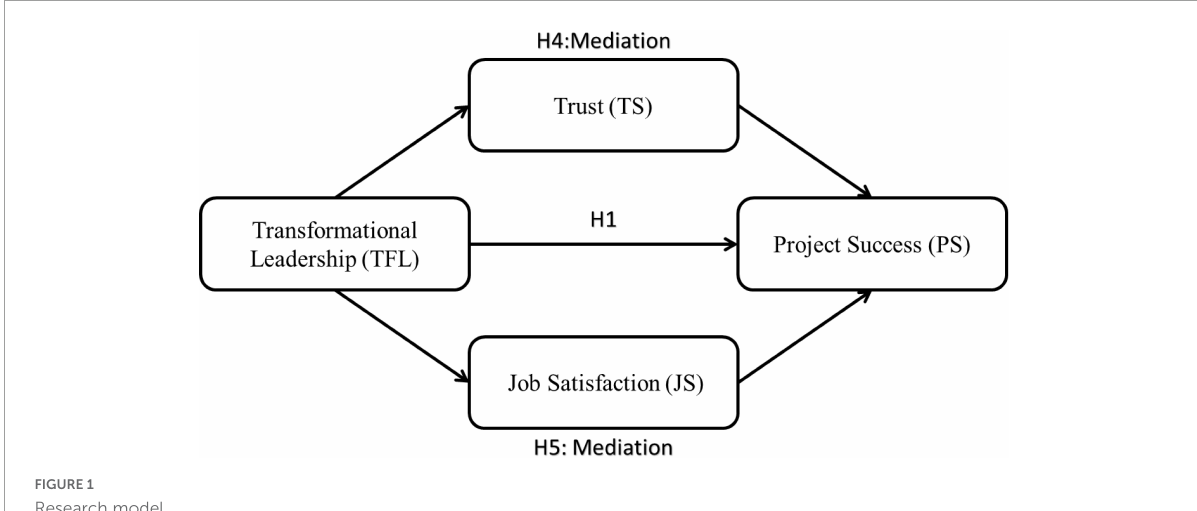
FIGURE1 Research